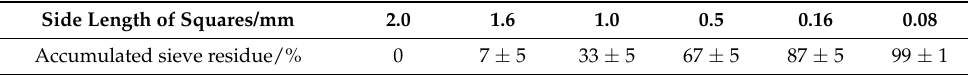
Table 5. Size distribution of standard